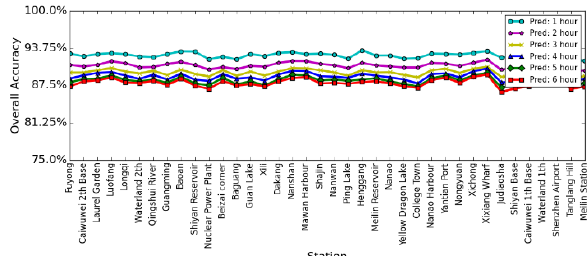
Figure 5.The overall accuracy of 2 hours time scale SVM for future different hours rainfall prediction Figure 6 and 7 show the TS scores of different sizes of training